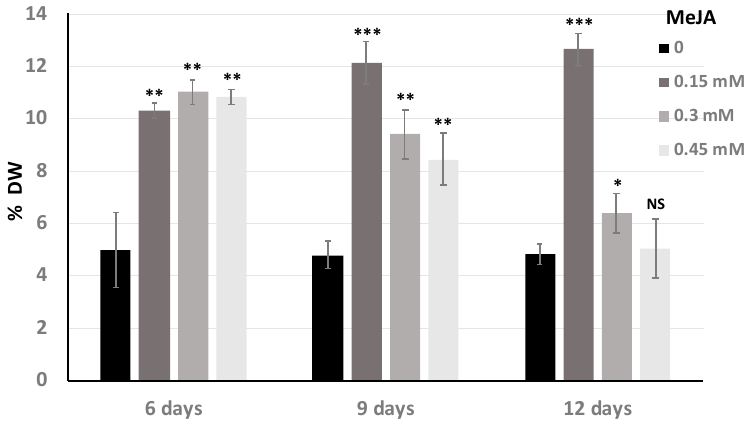
Figure 3. Effect of different concentrations of MeJA on the production of 3,5-dicaffeoylquinic acid (di-CQA) in the chicory hairy root line ‘Orchies 2659-31’. 0; 0.15; 0.3; 0.45 mM of MeJA indicates MeJA concentration in the culture medium. 6; 9; 12 days represents the duration of elicitation. DW: Dry weight. Statistics were achieved by a two-tailed t test using Prism GraphPad online tool (https://www.graphpad.com/quickcalcs/ttest1/). The mean with SD were calculated and plotted. *** p = 0.0001 to 0.001; ** p = 0.001 to 0.01; * p = 0.01 to 0.05; NS (Not Significant), p ≥ 0.05. All the conditions were compared to the control condition 0 mM MeJA.